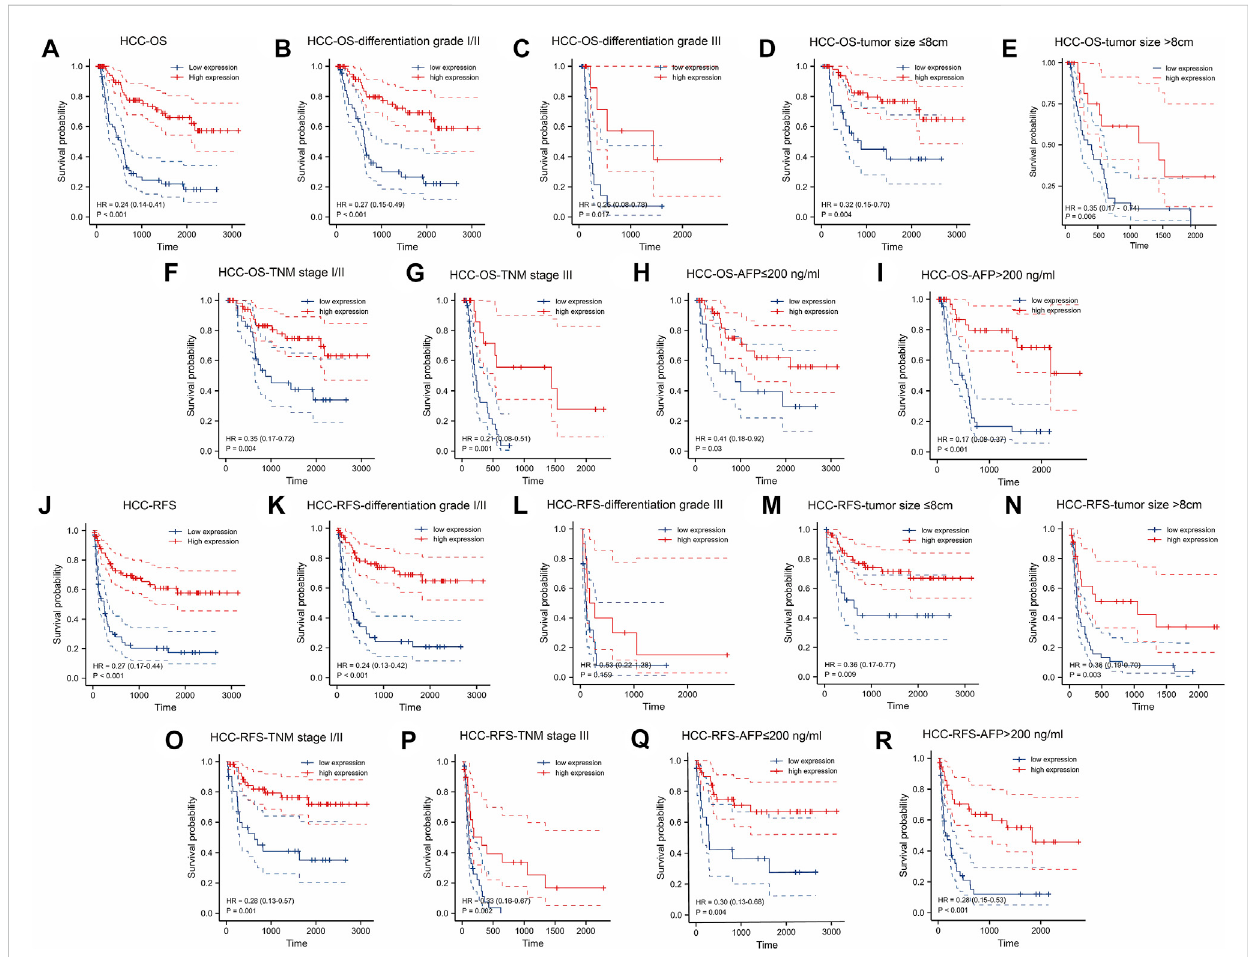
FIGURE 2 Association between expressed KLF4 level with OS and RFS in HCC cohort ( n = 141). Low expression of KLF4 is associated with poor OS (A) The OS between low-/high-KLF4 expression groups. Based on clinicopathologic characteristics, the OS in (B) differentiation grade I/II group (C) differentiation grade III group (D) tumor size ≤ 8 cm (E) tumor size > 8 cm (F) TNM I/II group (G) TNM III group (H) AFP ≤ 200 ng/ml group, and (I) AFP > 200 ng/ml were analyzedbyK-McureswithhighandlowKLF4expression.HighlyexpressedKLF4exhibitedalongerRFS.Analysisoftherelationshipsbetweenlow-/ high-expression KLF4 groups and RFS in (J) whole HCC cohort (K) differentiation grade I/II group (L) differentiation grade III group (M) tumor size ≤ 8 cm (N) tumor size > 8 cm (O) TNM I/II group (P) TNM III group (Q) AFP ≤ 200 ng/ml group, and (R) AFP > 200